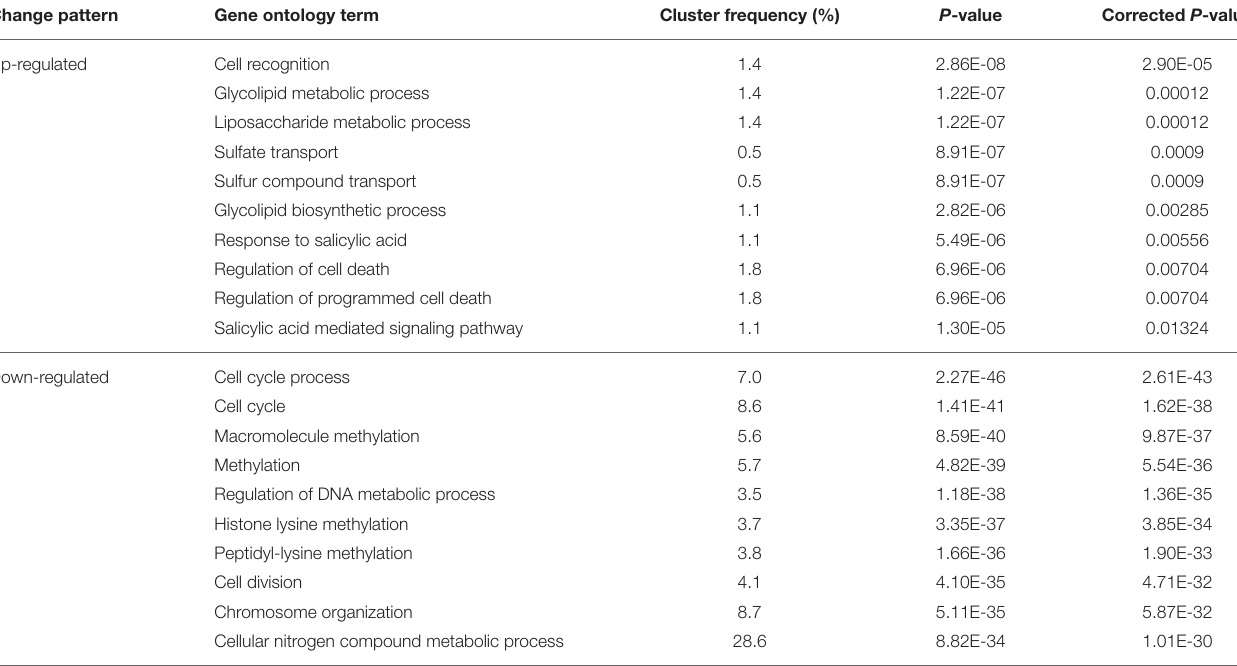
Top 10 most significant processes are displayed.